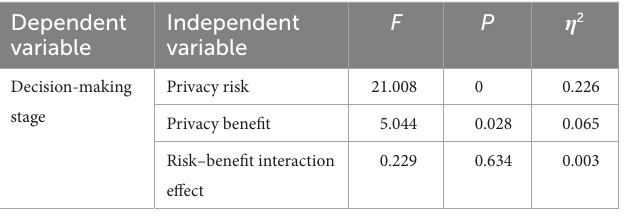
TABLE 2 ANOVA results for behavioral